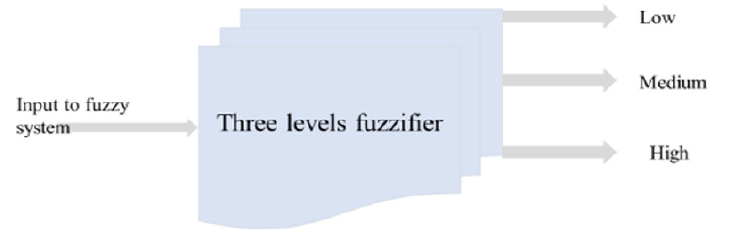
Figure 4. Fuzzification process of electric power from the solar panel fuzzy logic system.